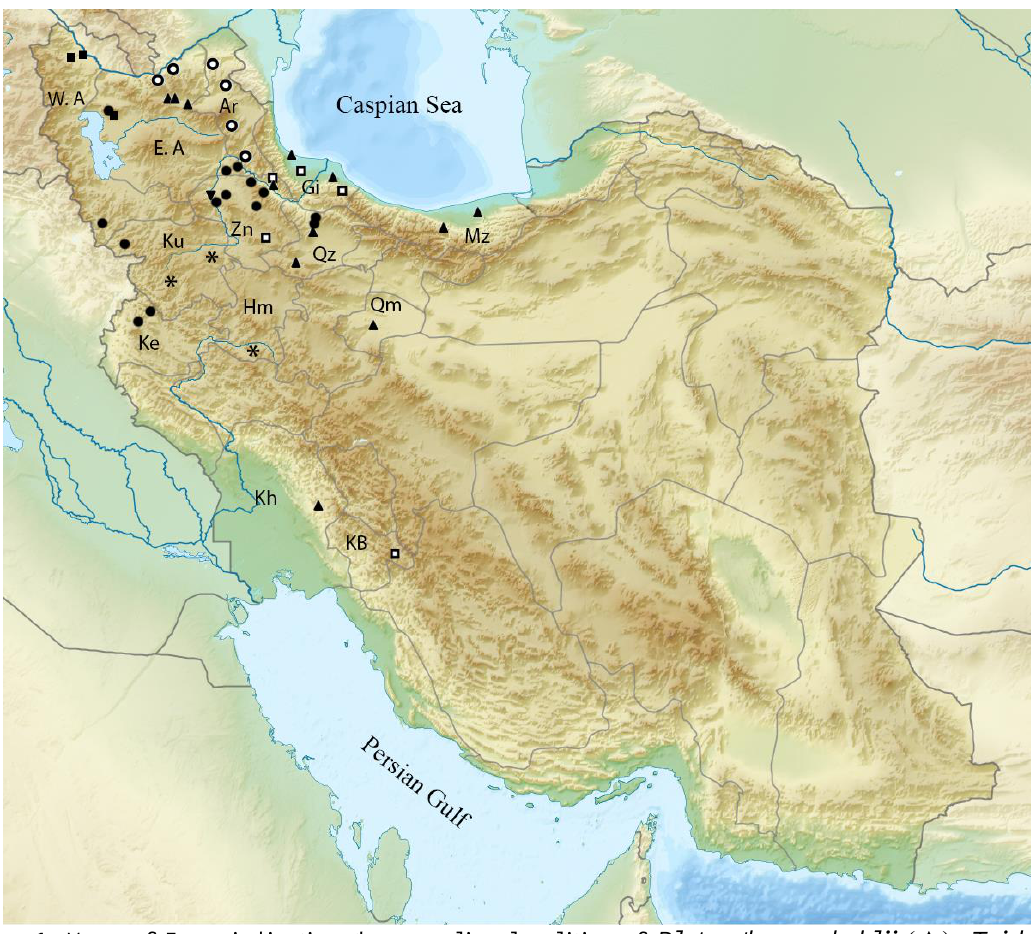
F IGURE 1. Map of Iran; indicating the sampling localities of Platyarthrus schoblii (▲), Trichorhina tomentosa (▼), Armadillo alievi (■), A. officinalis (  ), Armadillidium azerbaidzhanum (  ), A. nasatum (  ) and Schizidium golovatchi (●). Ar: Ardabil; E. A: Eastern Azarbaijan; Gi: Guilan; Hm: